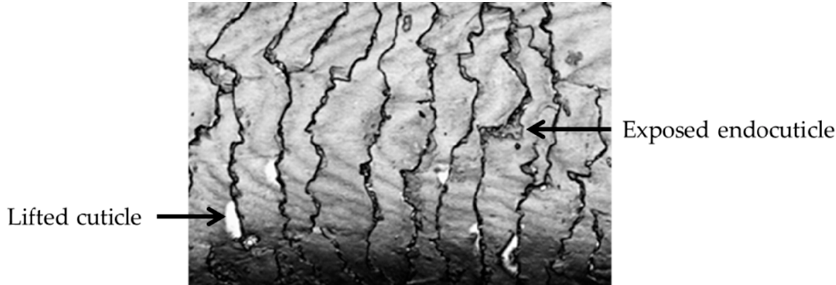
Figure 1. Image of damaged hair surface obtained with a profile microscope. Lifted cuticle, which is observed as white area, is caused by the splitting of the cell membrane complex between cuticle cells. Exposed endocuticle, which is seen as gray rough area, is caused by breakage of cuticle cell.